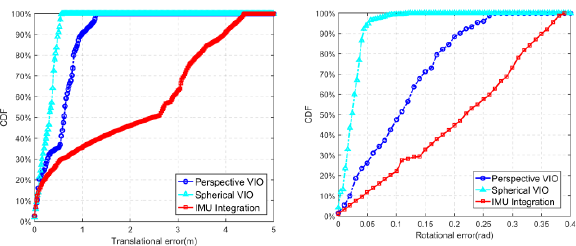
Figure 9. Left : Cumulative distribution of translational error for the perspective VIO, the omnidirectional VIO and the IMU integration. Right : Cumulative distribution of rotational